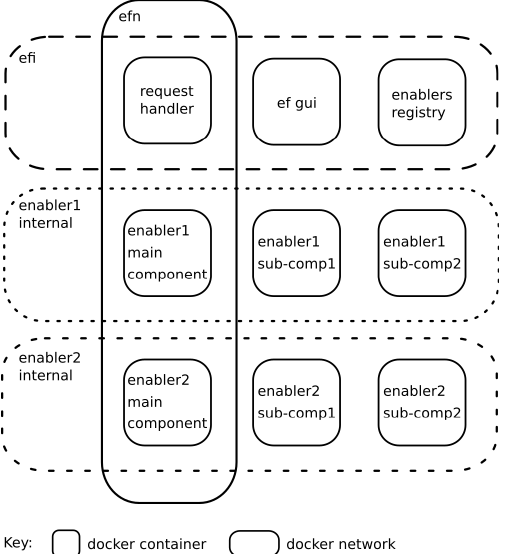
Figure 2. EF instantiation networks. The main enabler module can only be accessed through the Request Handler, an EF submodule.